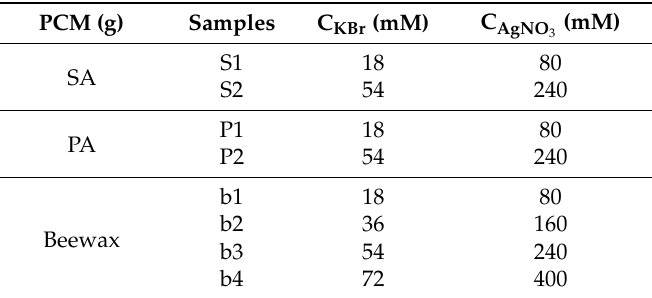
Table 1. Preparation of the samples with different phase change materials (PCMs) (Stearic acid (SA), palmitic acid (PA), and beeswax) by adjusting the concentrations of silver nitrate and potassium bromide in solutions.